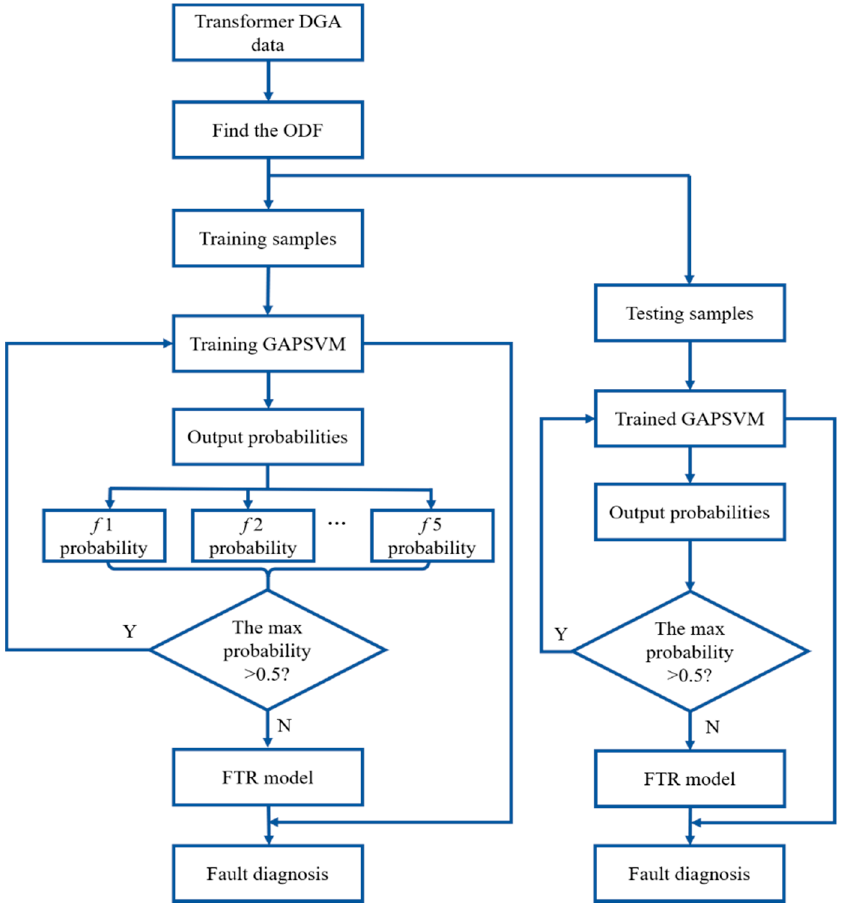
Figure 2. Flowchart of GAPSVM integrated with FTR.